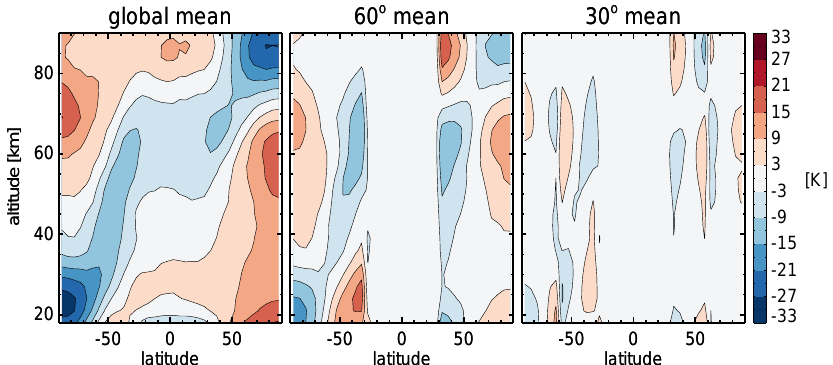
◦ ◦ (middle) and 30 (right) latitude bin profiles